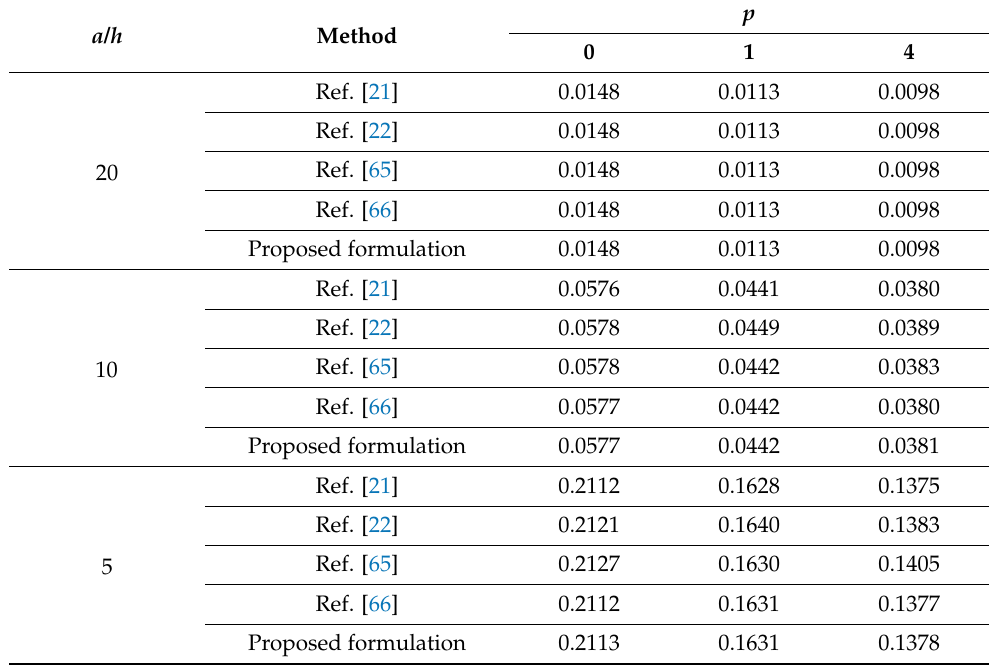
Table 2. Fundamental frequency (cid:101) ω for SS FG square plates.